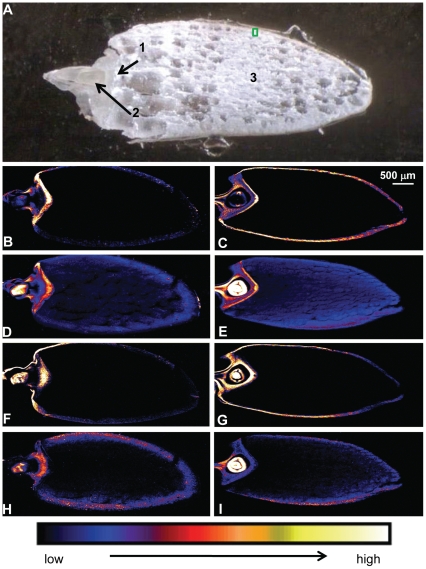
µ-XRF elemental maps of WT and OE-OsNAS2A longitudinal grain sections.WT grain had 23 µg g−1 DW Fe and 38 µg g−1 DW Zn while OE-OsNAS2A grain had 64 µg g−1 DW Fe and 80 µg g−1 DW Zn, as determined by ICP-OES. (A) Light microscopy photo of a representative grain section with numbers indicating the location of scutellum (1), embryo (2) and endosperm (3); the green box represents the area used to obtain the line scans in Figures 5–6. (B–I) Elemental maps of Fe distribution in WT (B) and OE-OsNAS2A (C) grain; Zn distribution in WT (D) and OE-OsNAS2A (E) grain; Mn distribution in WT (F) and OE-OsNAS2A (G) grain; Cu distribution in WT (H) and OE-OsNAS2A (I) grain. The colour scale represents different elemental concentrations, with black and white corresponding to the lowest and highest concentrations, respectively.